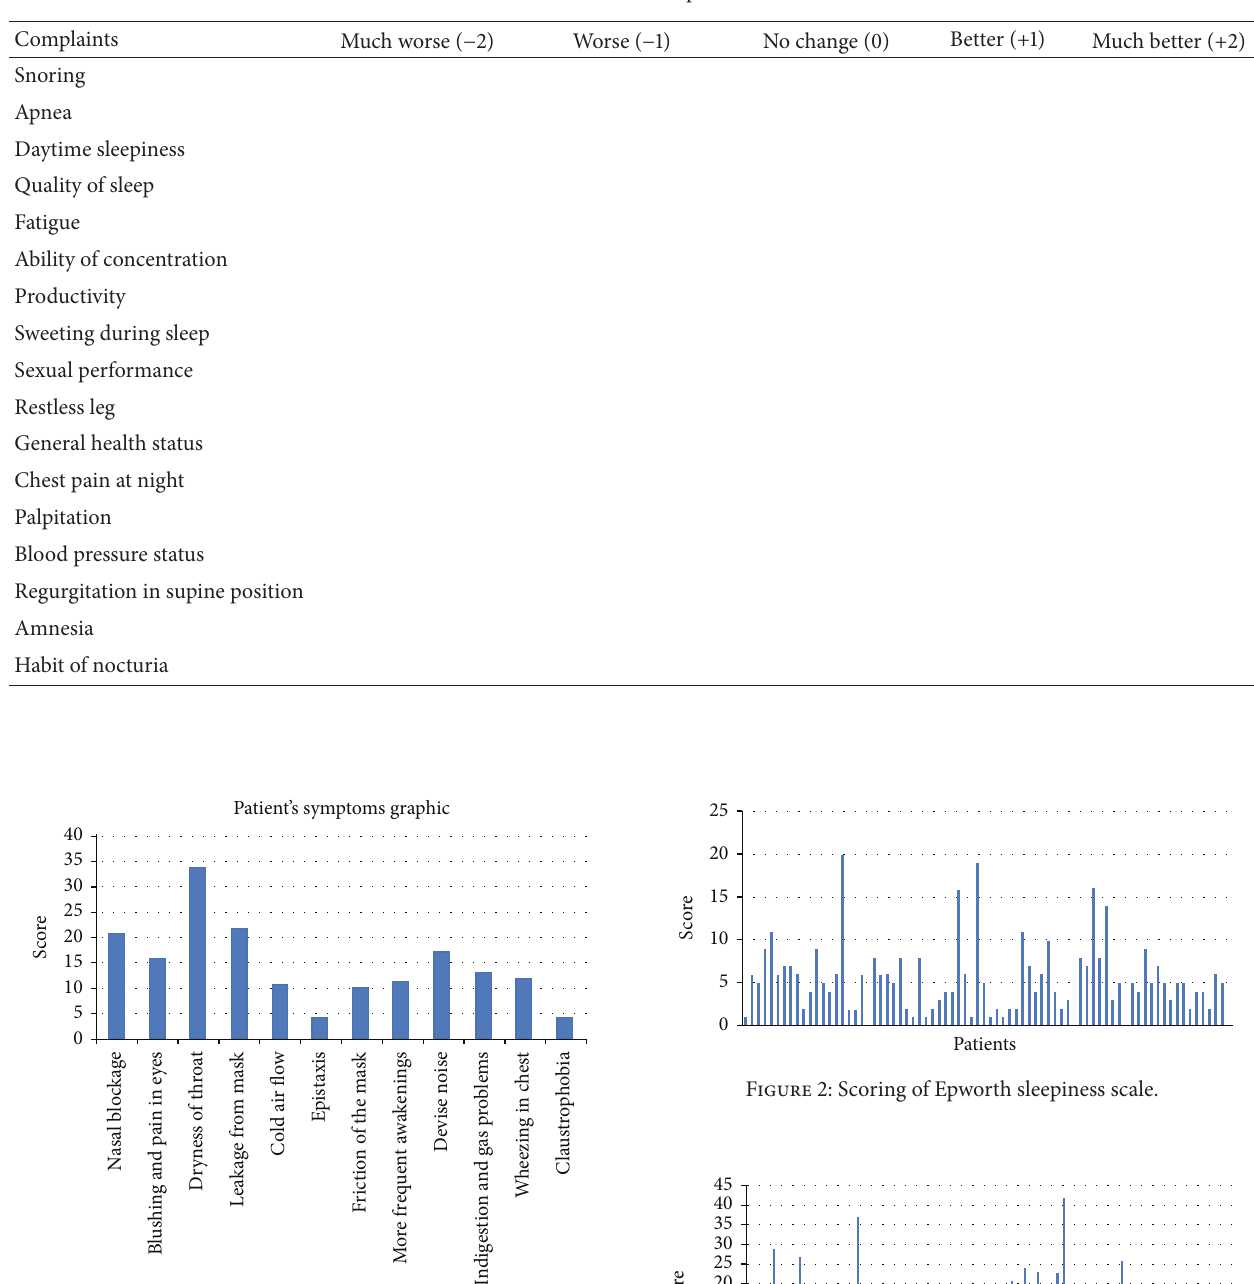
Table 3: Definition of alteration of complaints after PAP treatment.